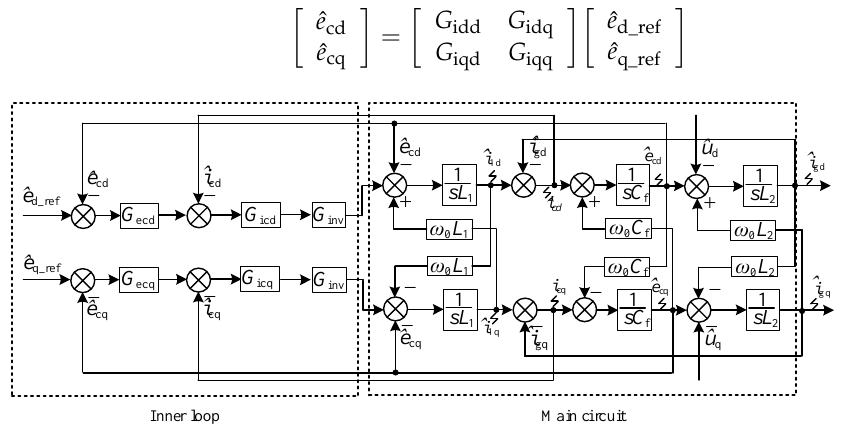
Figure 3. System diagram of inner loop.